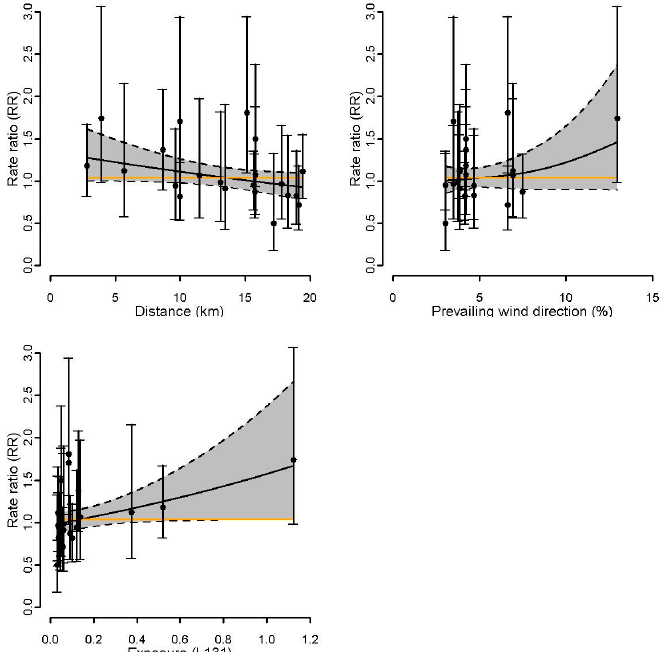
Figure 4. Mol-Dessel: Rate ratios and 95% CI (gray area) of thyroid cancer incidence within the 20 km proximity areas as a smooth function of 1: residential proximity to the nuclear site, 2: prevailing wind directions, and 3: I-131 estimates. The orange line represents the constant RR. The dots represent the commune-specific RRs with their 95% CI.